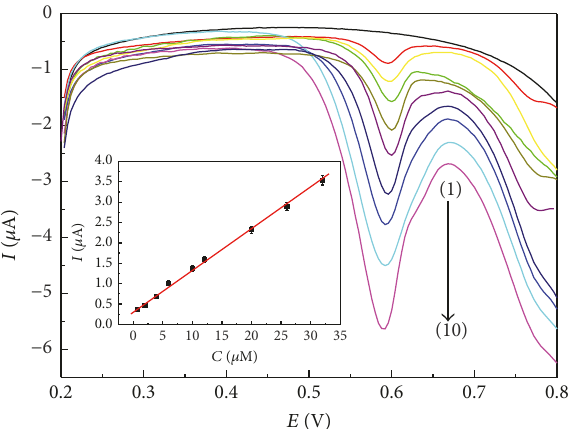
Figure 5: DPV curves at the ERGO/GC electrode for an increasing concentration of trans -resveratrol in the 0.04 M BR buffer solution (pH 2.0): (1) 0, (2) 0.8, (3) 2, (4) 4, (5) 6, (6) 10, (7) 12, (8) 20, (9) 26, and (10) 32 𝜇 M. Inset shows the calibration curve of oxidation peak current versus concentration.